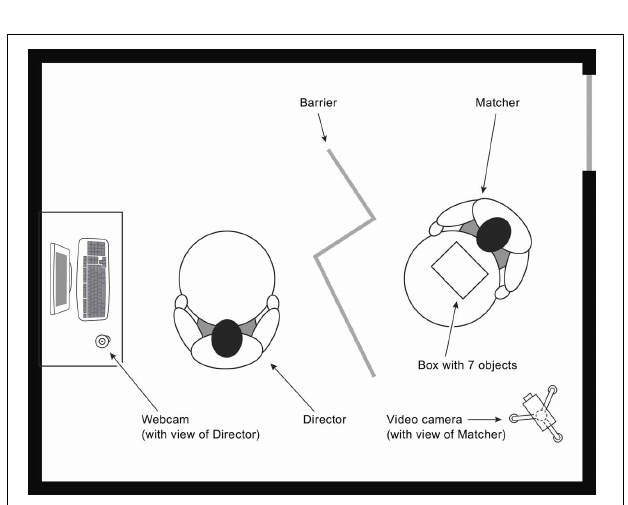
FIGURE 2 | Set-up of our studies, showing the Director’s and Matcher’s working stations, and the locations of recording devices. This example of a description phase illustrates the conditions of Galati et al. (2013) in which Directors and Matchers were misaligned by 135 ◦ , and the conditions of Galati and Avraamides (in revision) in which Directors were aligned with the intrinsic structure (with Matchers misaligned by 135 ◦ ).